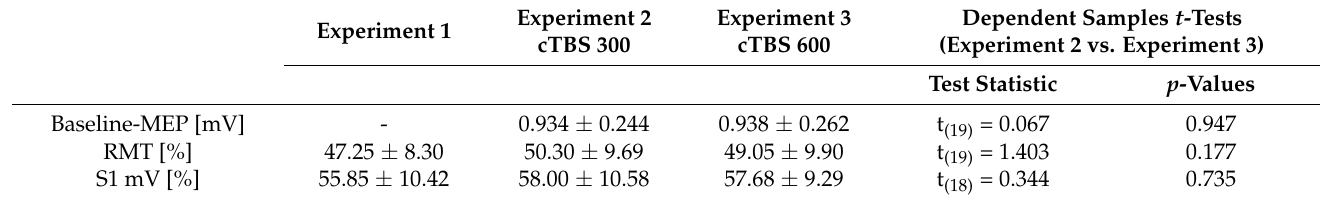
Table 1. Baseline motor-evoked potentials (MEP, monophasic), resting motor thresholds (RMT, monophasic in Experiment 1 and biphasic in Experiments 2 and 3), and intensities to evoke MEP of approximately 1 mV (S1 mV, monophasic in experiment 1 and biphasic in Experiments 2 and 3). To ensure comparability between both cTBS experiments, we computed paired samples t -tests comparing the baseline neurophysiological measures of Experiments 2 and 3. The respective analyses obtained no significant differences. Note: S1 mV data of one participant were excluded due to incomplete data acquisition. Data are shown as mean values ± standard deviation. mV: millivolt; %: percentage of stimulator